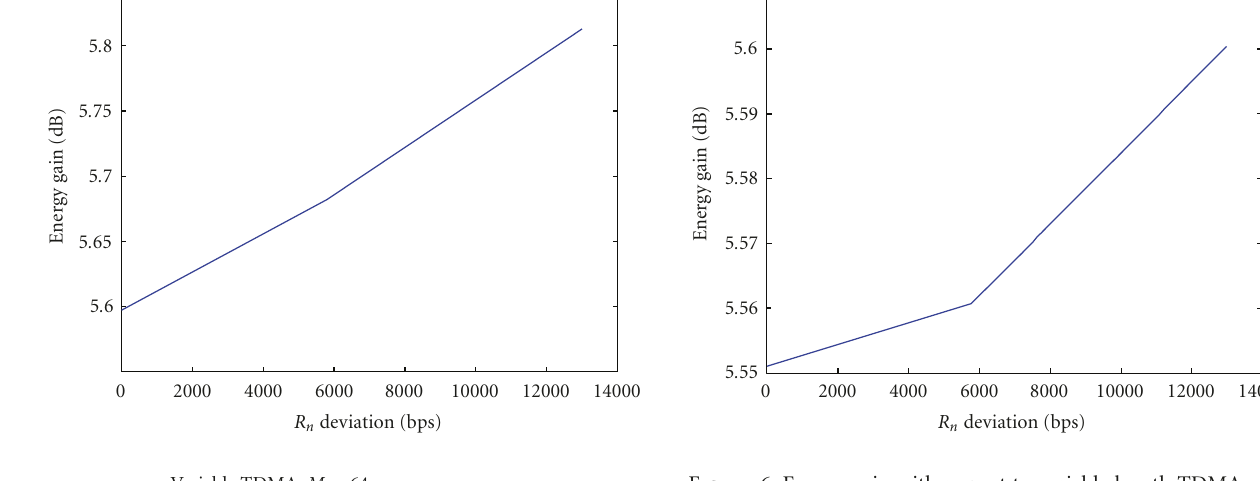
Figure 6: Energy gain with respect to variable length TDMA with 64-QAM modulation, N = 64 symbol periods. Table 1: Energy gain for energy-e ffi cient adaptive modulation com- pared to conventional TDMA with di ff erent correlations between channels ( σ 2 ), N = 896